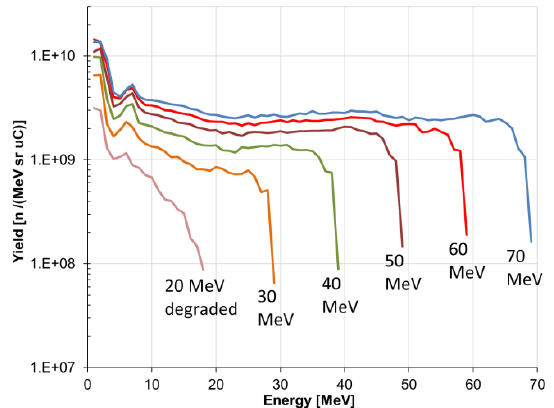
Fig. 3. Simulated (MCNPX) fast neutron spectra in the forward direction for different proton beam energies.